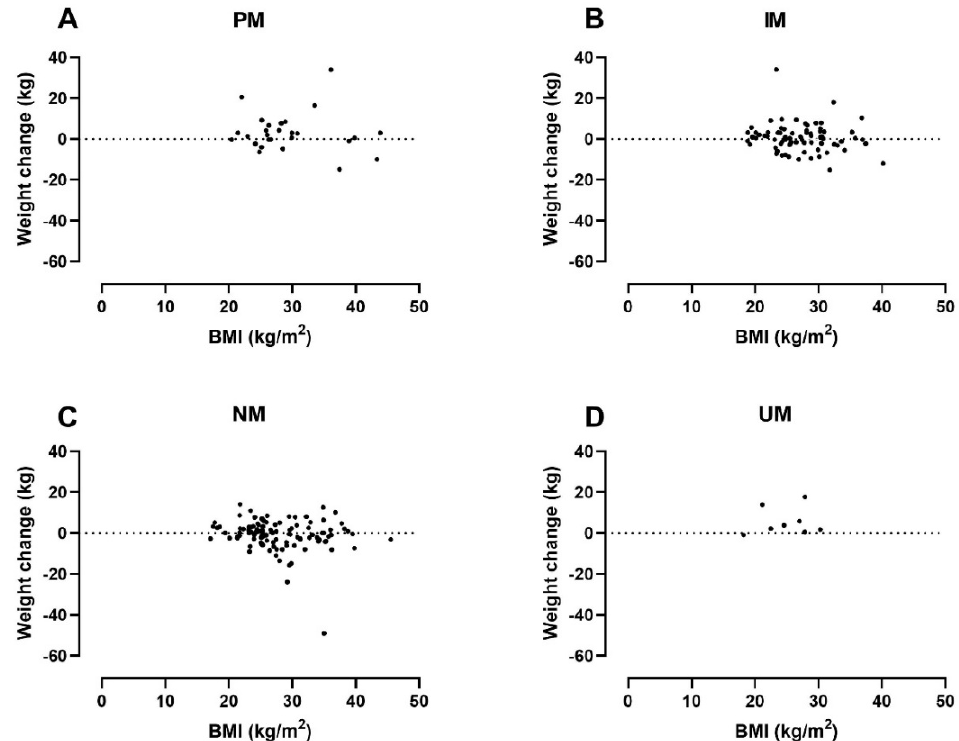
Figure 2. Weight change by baseline body mass index (BMI) and CYP2D6 genotyp in: PMs (=Poor metabolizers) ( A ); IMs (=Intermediate metabolizers) ( B ); NMs (=Normal metabolizers) ( C ) and UMs (=Ultrarapid metabolizers) ( D